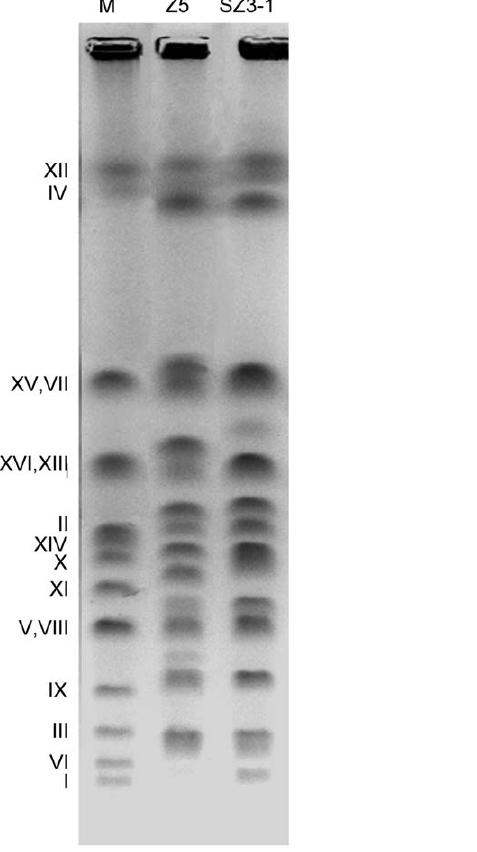
Figure 6. Karyotype profiles of strains Z5 and SZ3-1 obtained by PFGE. Lanes M, Z5 and SZ3-1 respectively represent the chromosomal profiles of strains BY4743, Z5 and SZ3-1. Numbers corresponding to each band are designated in the left.